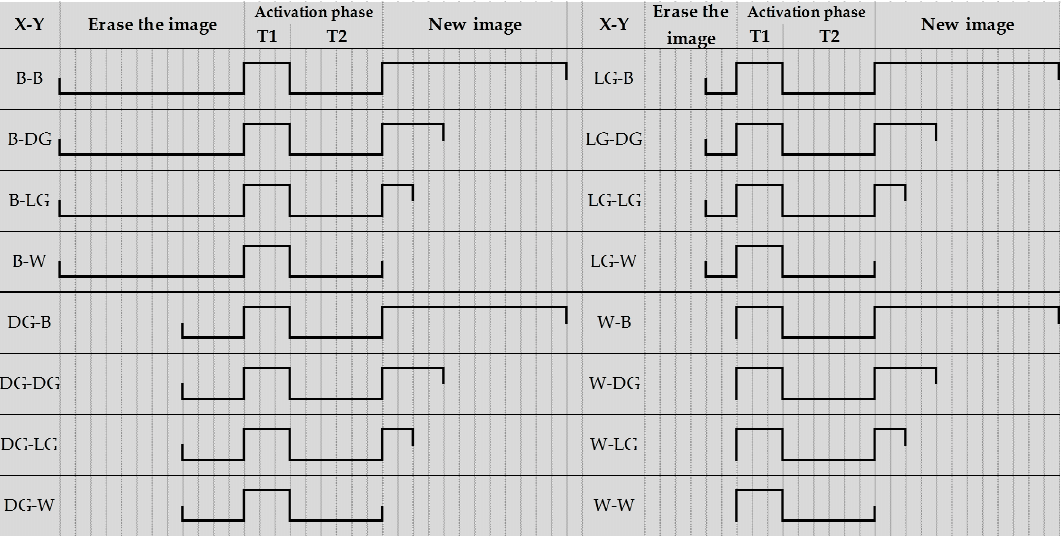
Figure 7. A four-level grayscale driving waveform set. X is displayed as an original grayscale, and Y can be displayed when the EPD has been driven by the driving waveform.